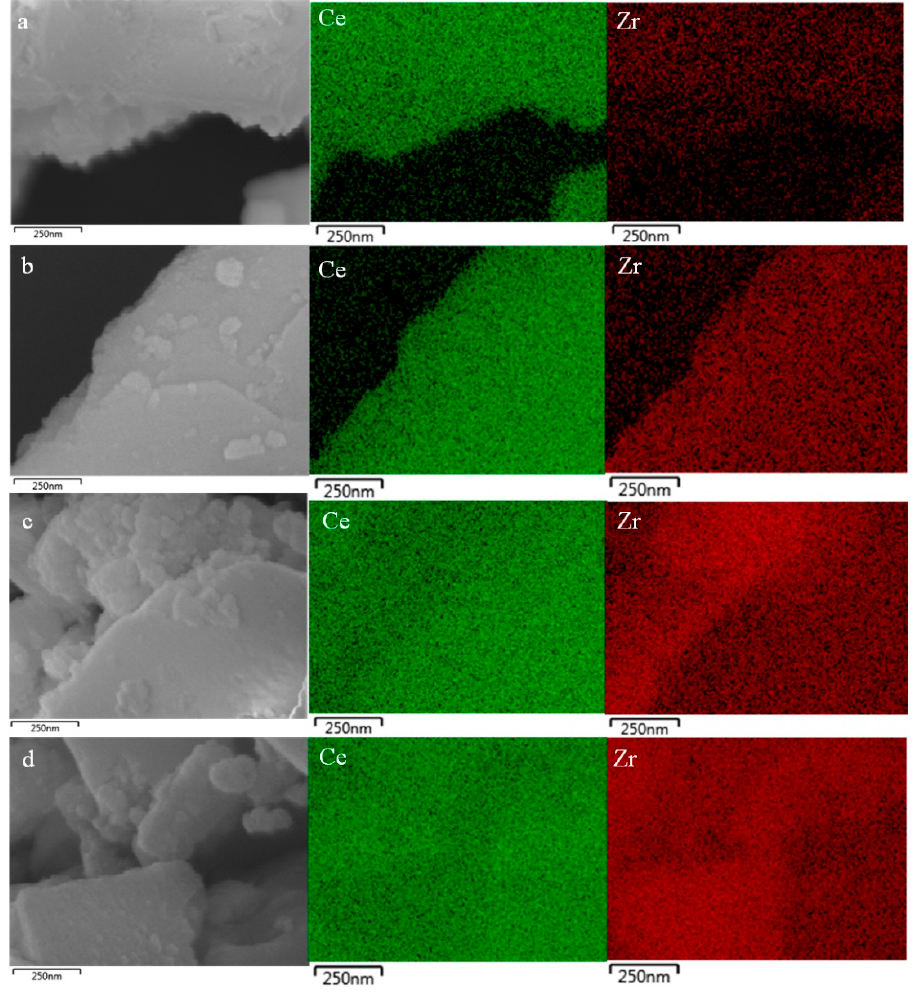
Figure 6. SEM-EDX mapping of ( a ) Ce 0.95 Zr 0.05 O x , ( b ) Ce 0.90 Zr 0.10 O x , ( c ) Ce 0.75 Zr 0.25 O x , and ( d ) Ce 0.50 Zr 0.50 O x prepared mechanochemically using carbonate precursors. Showing cerium (green) and zirconium (red).